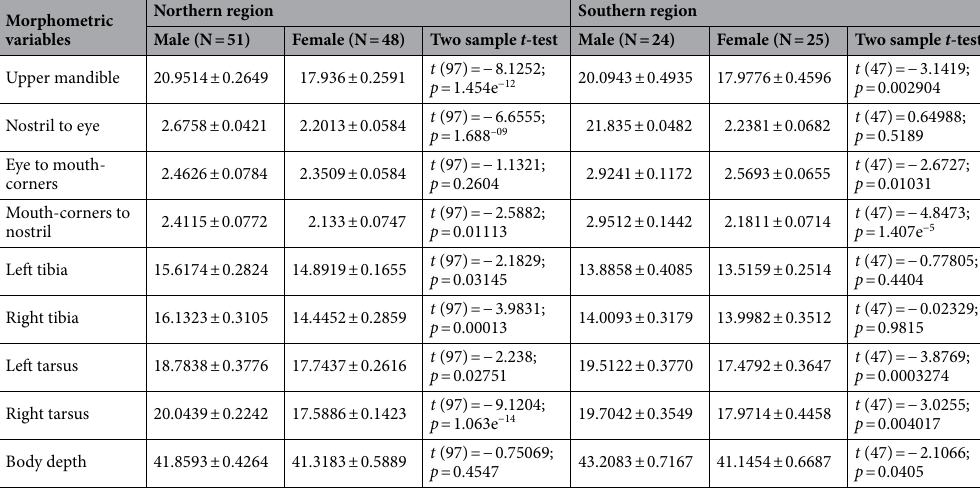
Table 1. Summary of the morphological variables of Painted Storks measured in units (cm) from two (North and South) regions of India, represented with the mean (± SE) and the p-values indicate the statistical differences between males and